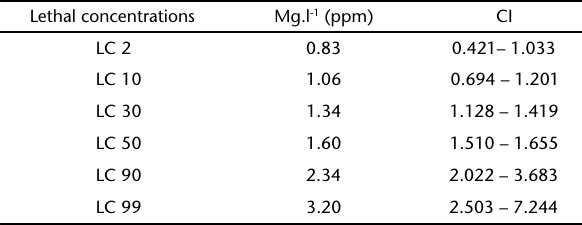
Table I. Lethal concentrations (LC) of phenanthrene for the acute exposure of Chironomus sancticaroli , expressed in mg.l -1 , with confidence interval